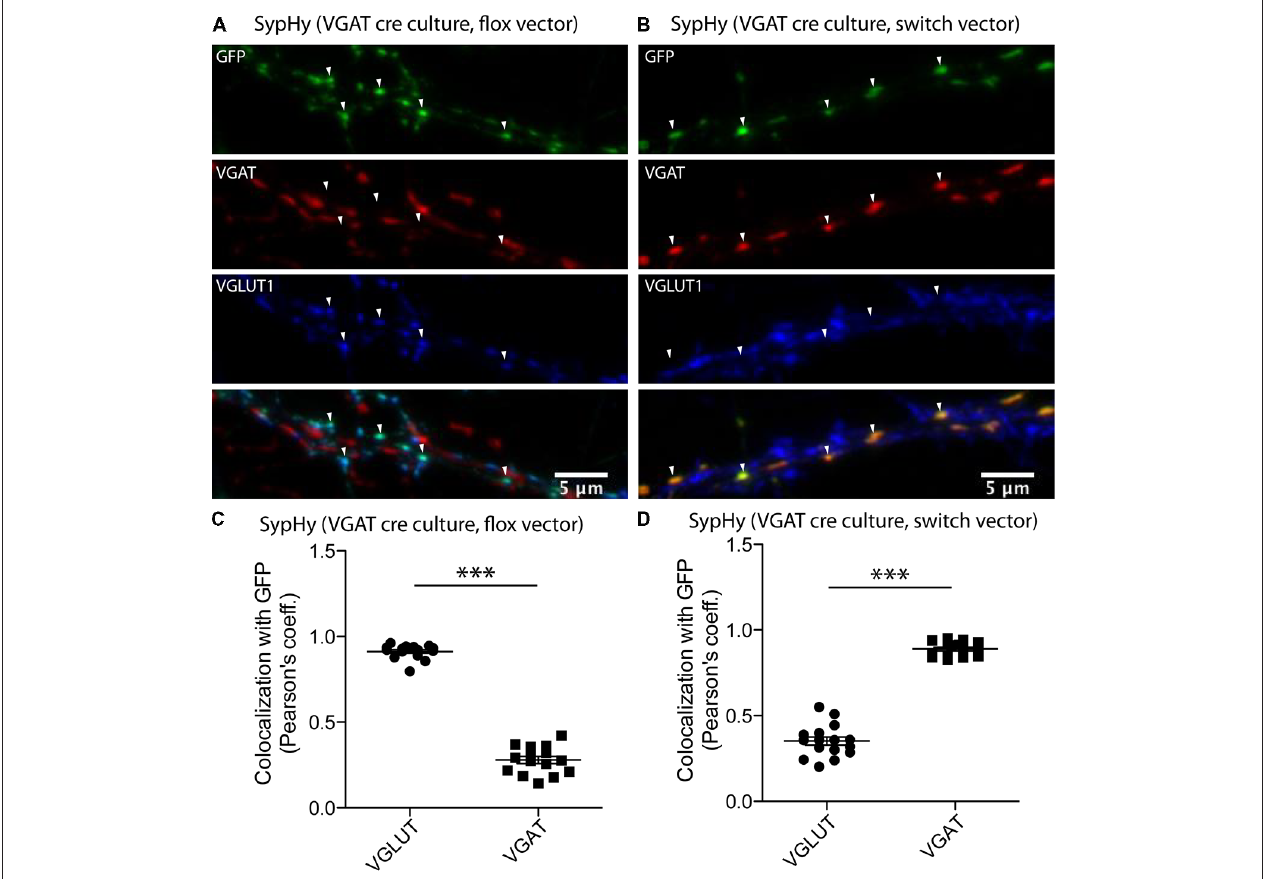
FIGURE 1 | Synapse specific expression of synaptophysin pHluorin (SypHy) in vesicular GABA transporter (VGAT)-Cre culture synapses using flox/SWITCH expression vectors. Representative images of immunofluorescence from GFP (green, SypHy, vesicular glutamate transporter (VGLUT1; blue) and VGAT (red) in hippocampal VGAT-Cre cultures expressing SypHy by flox (A) or SWITCH (B) expression vectors. Arrows indicate GFP-positive regions of interest. (C) Colocalization of SypHy labeled with anti-GFP with either immunofluorescence for VGLUT1 or VGAT when SypHy is expressed by the flox expression vector in VGAT-cre hippocampal cultures. n = 15 images, three independent cultures. (D) Same as (C) , but with SypHy expressed by SWITCH vector. n = 16 images, three independent cultures. Colocalization determined by Pearson’s coefficient (r). Significance determined by paired t -test. ∗∗∗ p <